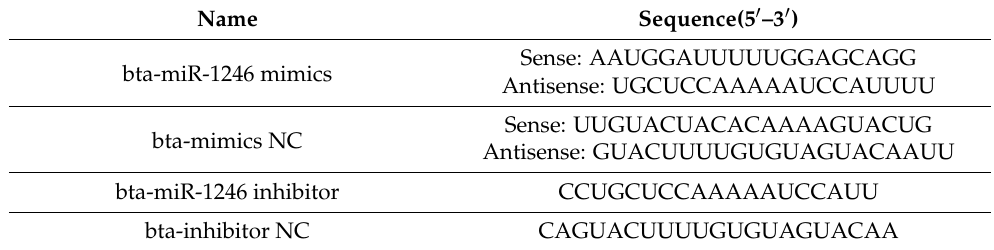
Table 1. Sequences of miR-10b and mimics NC.